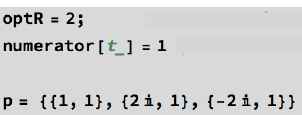
Figure 10. Part of the structure of the [SInt] algorithm corresponding to Option 2 to input r .